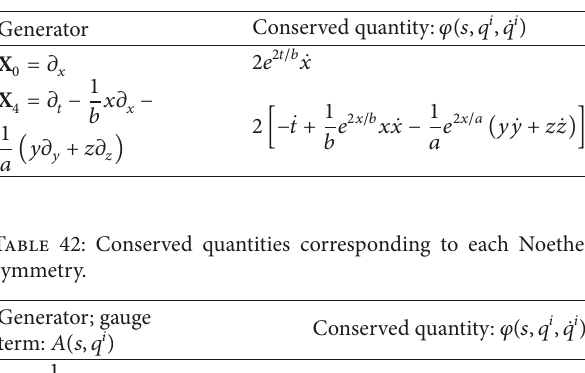
Table 41: Conserved quantities corresponding to each Noether symmetry.